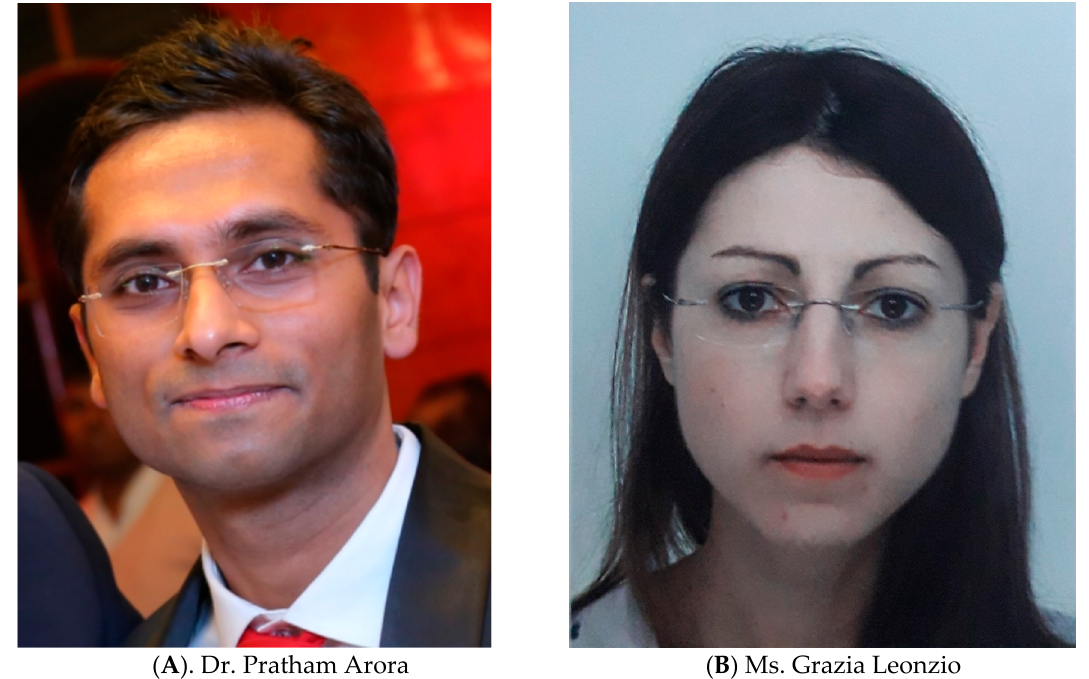
Figure 1. The winners of 2019 Processes Travel Awards. ( A ). Dr. Pratham Arora, ( B ) Ms. Grazia